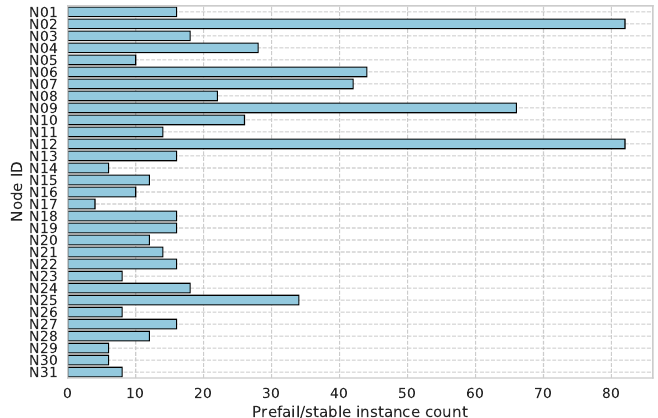
Figure 11. Prefail/stable instance count by sensor.